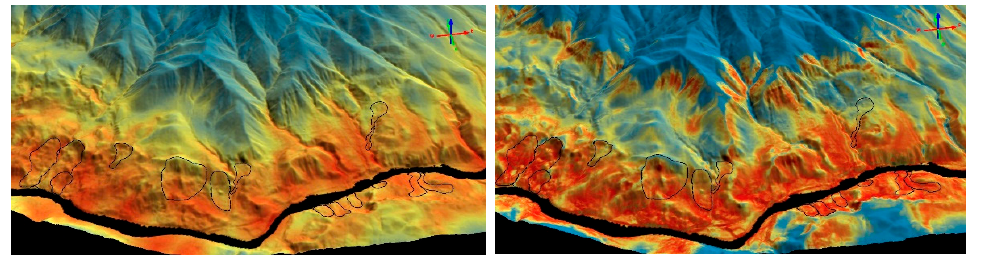
from the comparison between 2012 and 2018 DTMs of the study area. Dam construction area is shown